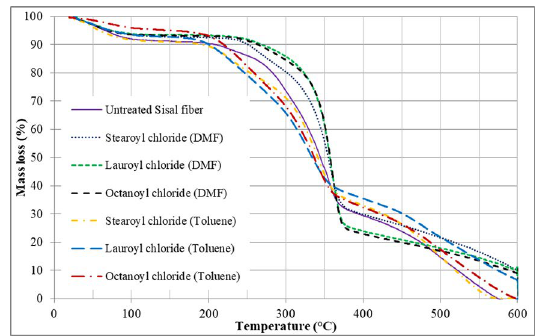
Figure 3. TGA curves of untreated sisal fibre and modified fibres.